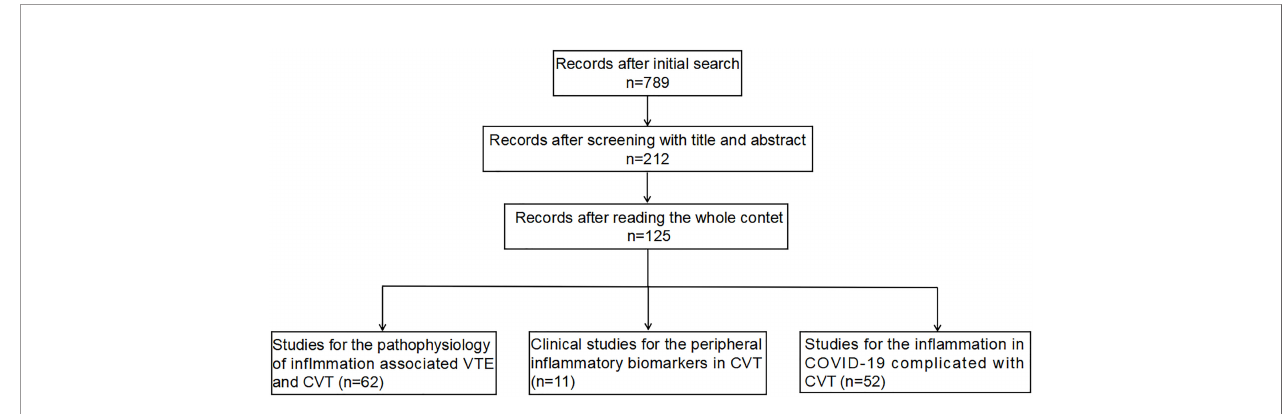
FIGURE 1 | The selection fl owchart for this